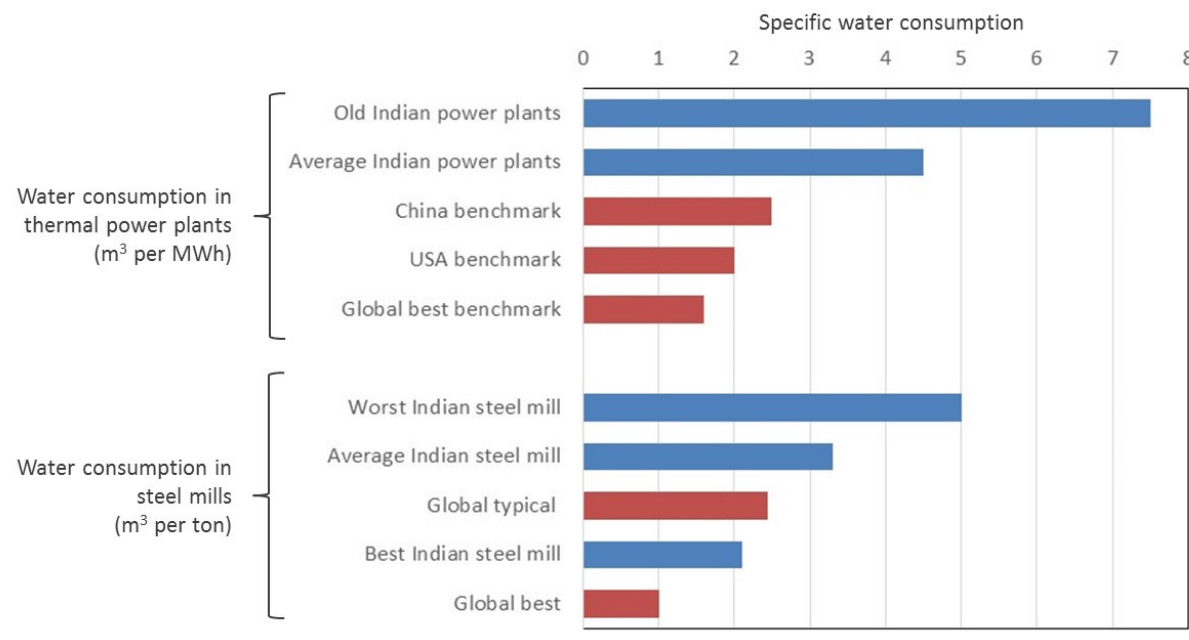
Figure 11. Most thermal power plants in India use freshwater recirculating cooling systems, with high rates of evaporative water consumption.